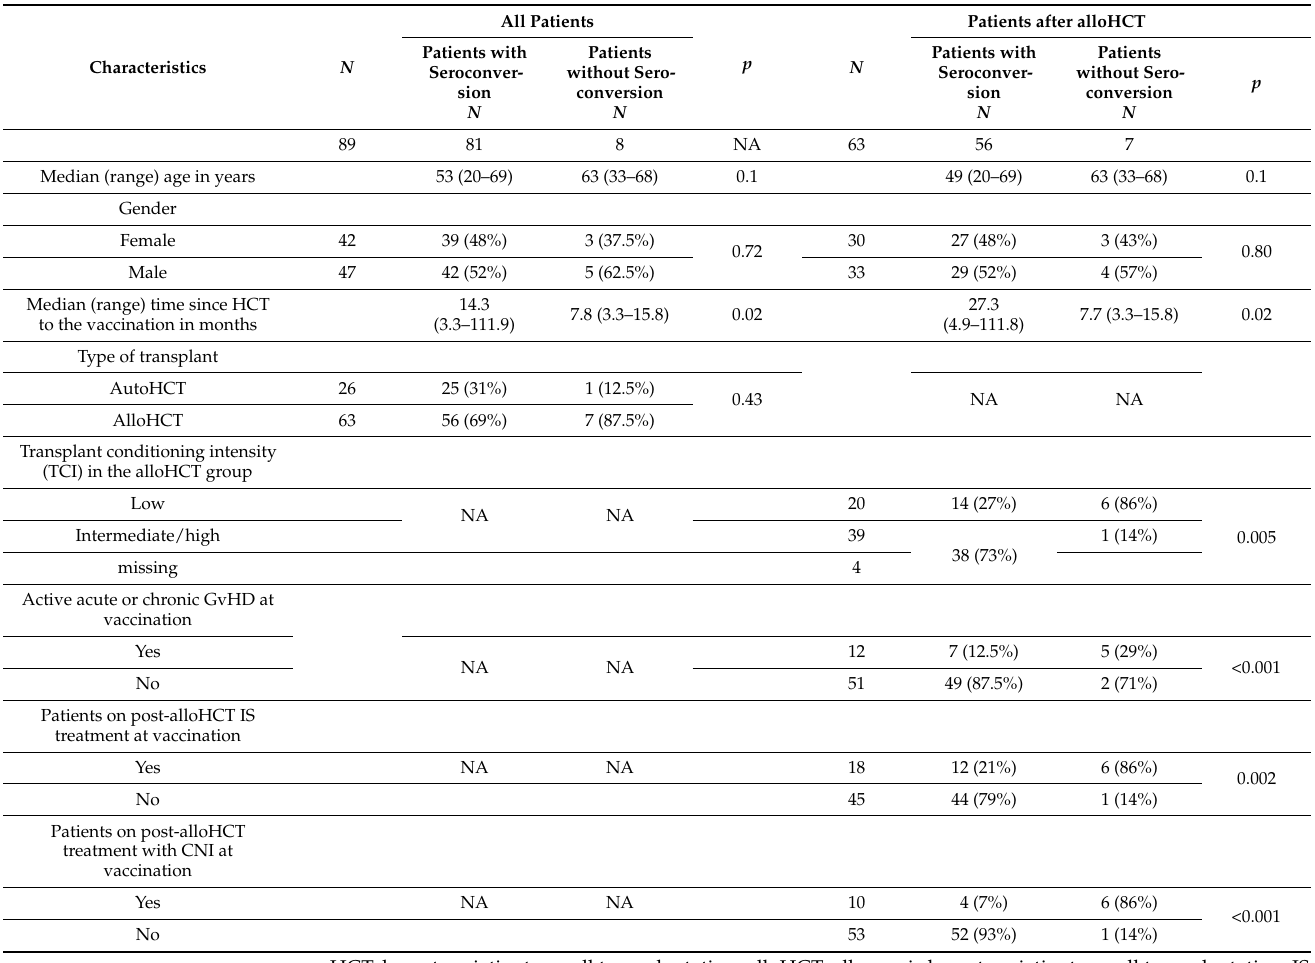
Table 4. Patients’baselinecharacteristicsatSARS-CoV-2vaccinationbyserologicalconversionaftervaccination.